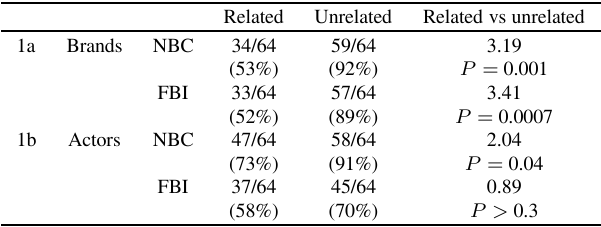
Table 2 Number and percentage correct responses in each related and unrelated